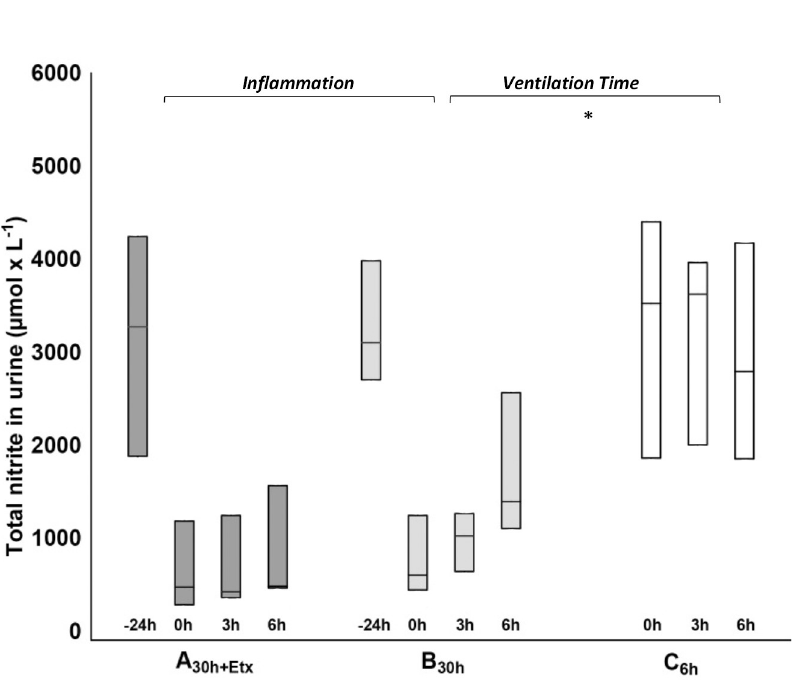
Fig 5. Total nitrite in urine. Total nitrite concentration (after conversion of nitrate to nitrite) in urine at -24 h in groups A 30h+Etx (dark grey) and B 30h (light grey), and in all groups during the bacterial phase 0, 3 and 6 h. Experimental part Inflammation A 30h+Etx vs. B 30h (p 0.30) and Ventilation Time B 30h vs. C 6h (white), � denotes p < 0.05 in Ventilation Time . Mann-Whitney from mean concentration value in the bacterial phase 0–6 h. Median (HQ/LQ).